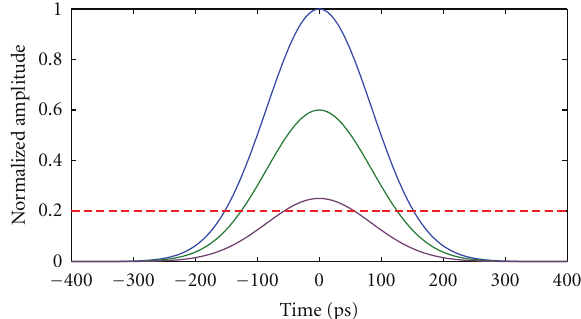
Figure 11: Random walk error-trigger time dependency on thresh- old level.